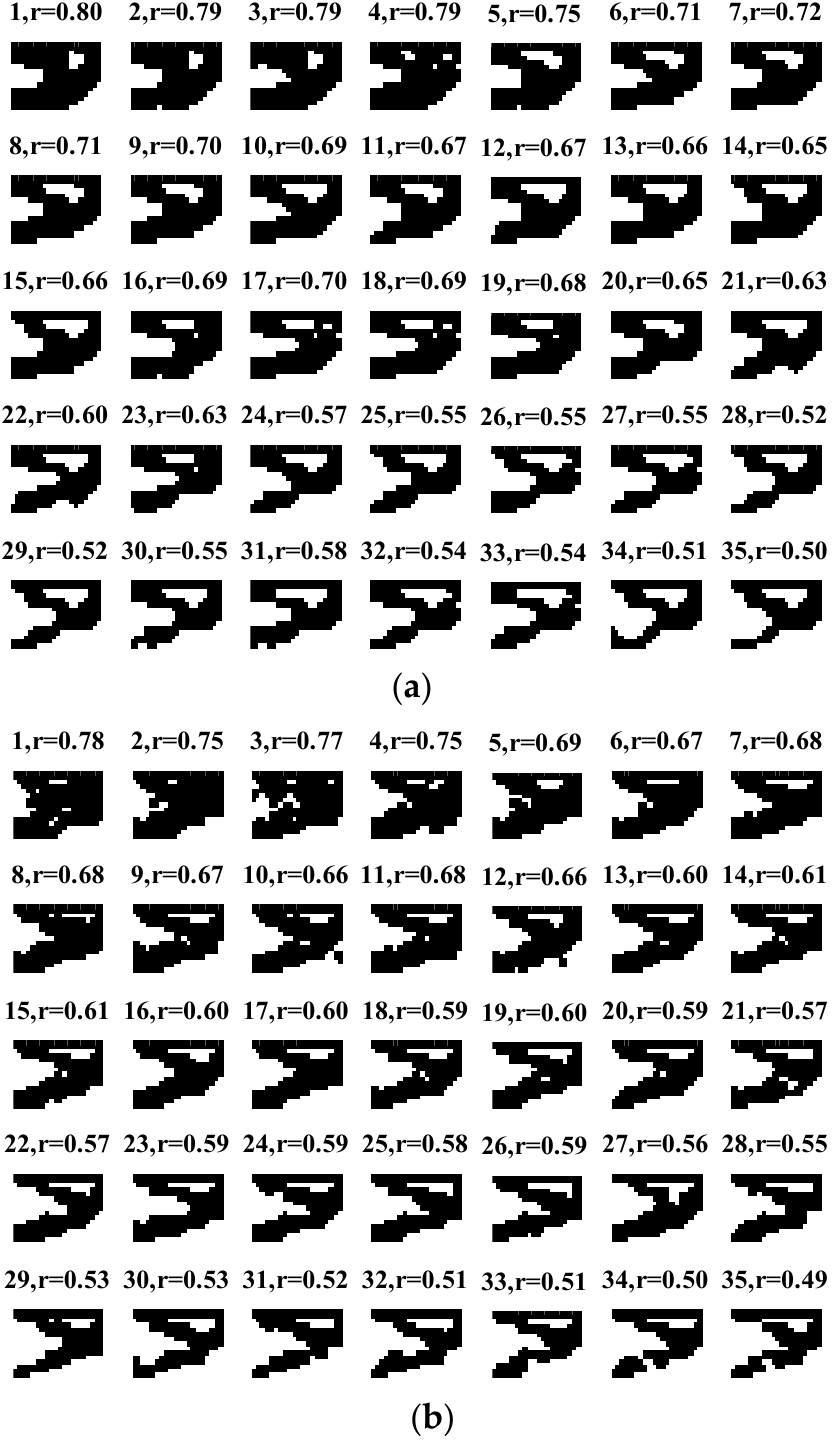
Figure 5. Topologies of MOP2: ( a ) OMPBIL with multi-grid; and ( b ) MPBIL without multi-grid.